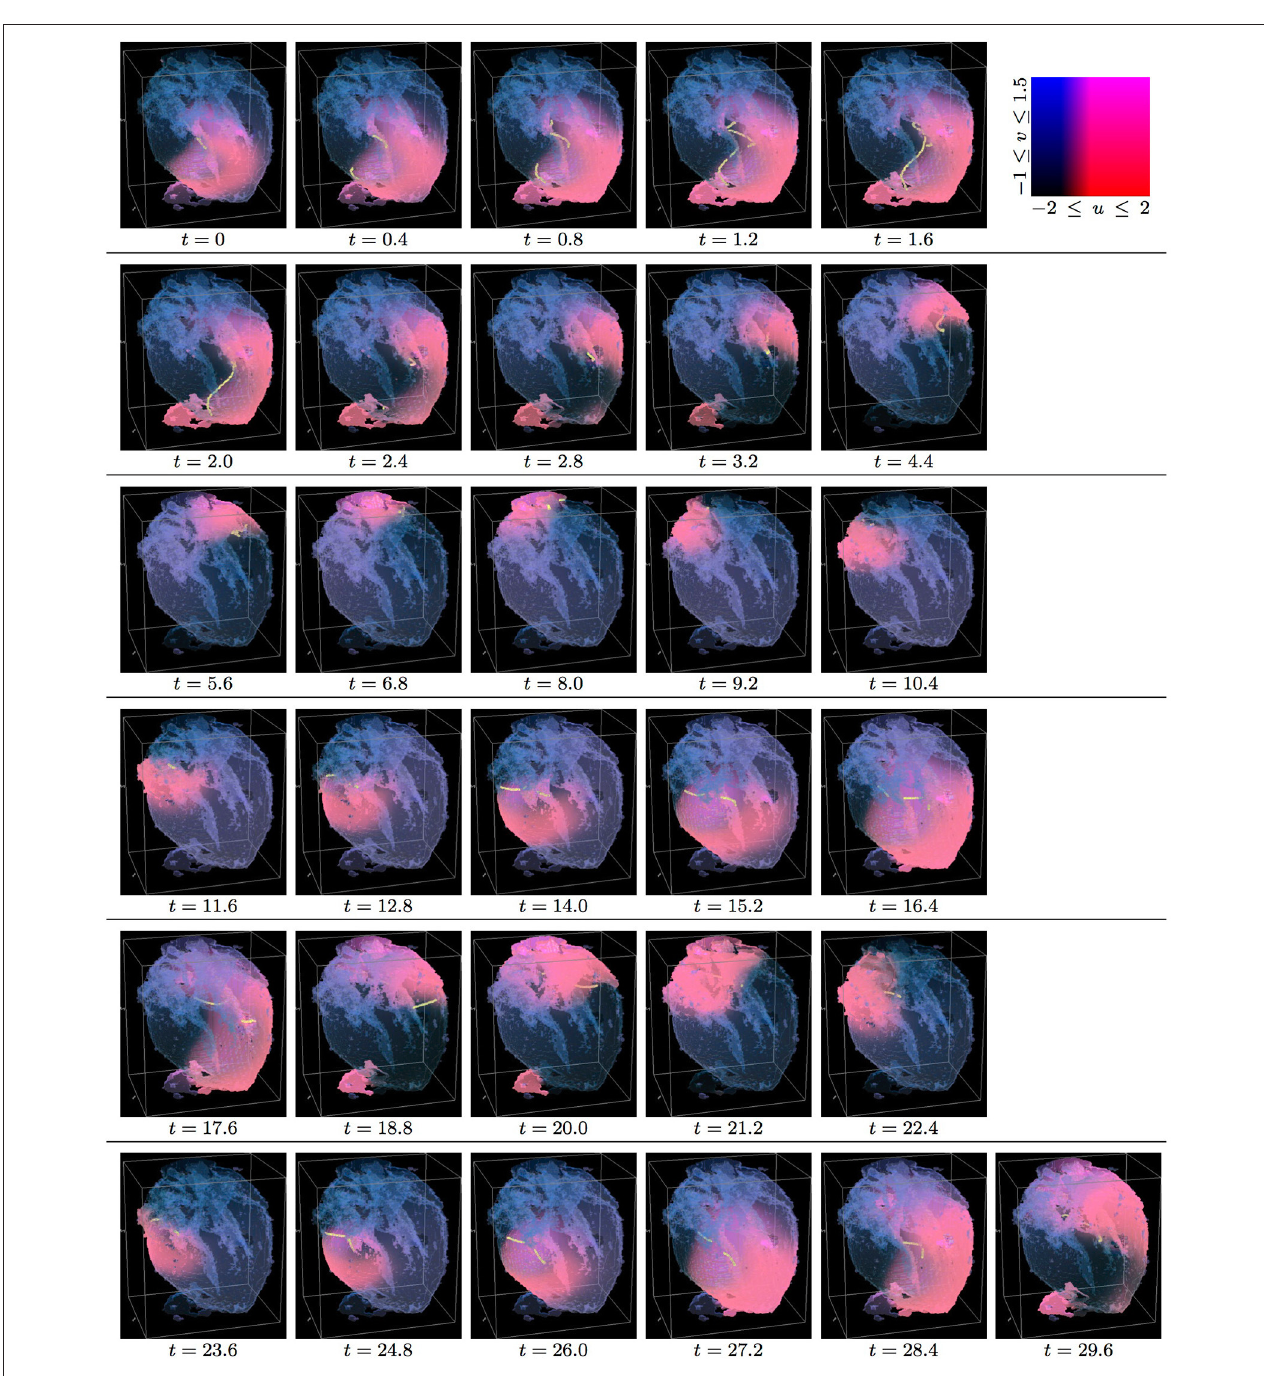
FIGURE 3 | Isotropic whole heart simulation. The translucent fetal heart is shown in blue, excitation front shown in red (see the color box in this figure), the yellow lines are the instant organizing filaments of the excitation vortices; time shown under each panel in time units of Equations (1, 2). After a short transient the organizing filament of the initial vortex breaks into the two short pieces each of which finds its own synchronous perpetual pathway, resulting in the perpetual cardiac re-entry in the fetal heart (See Supplementary Video 3 ).